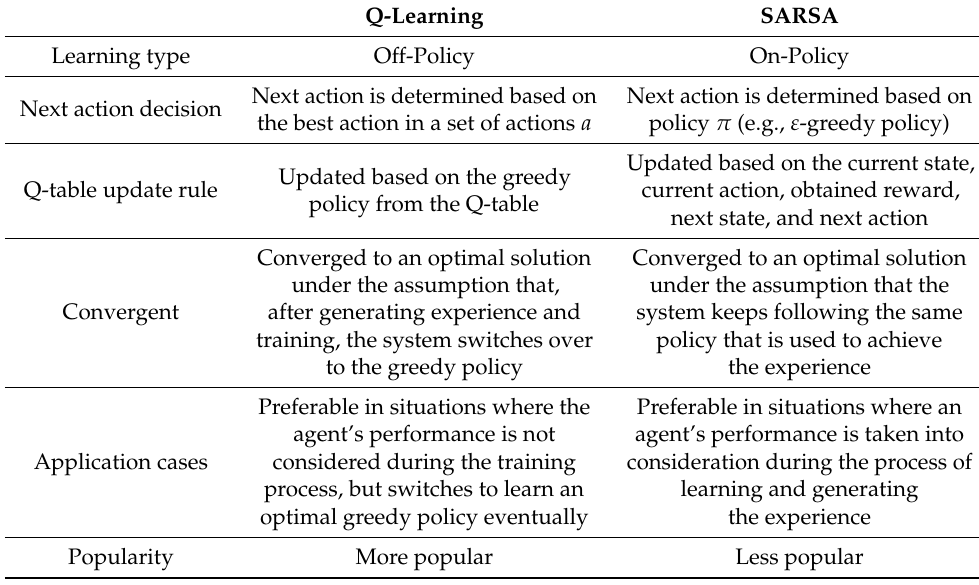
Table 1. Q-Learning and SARSA